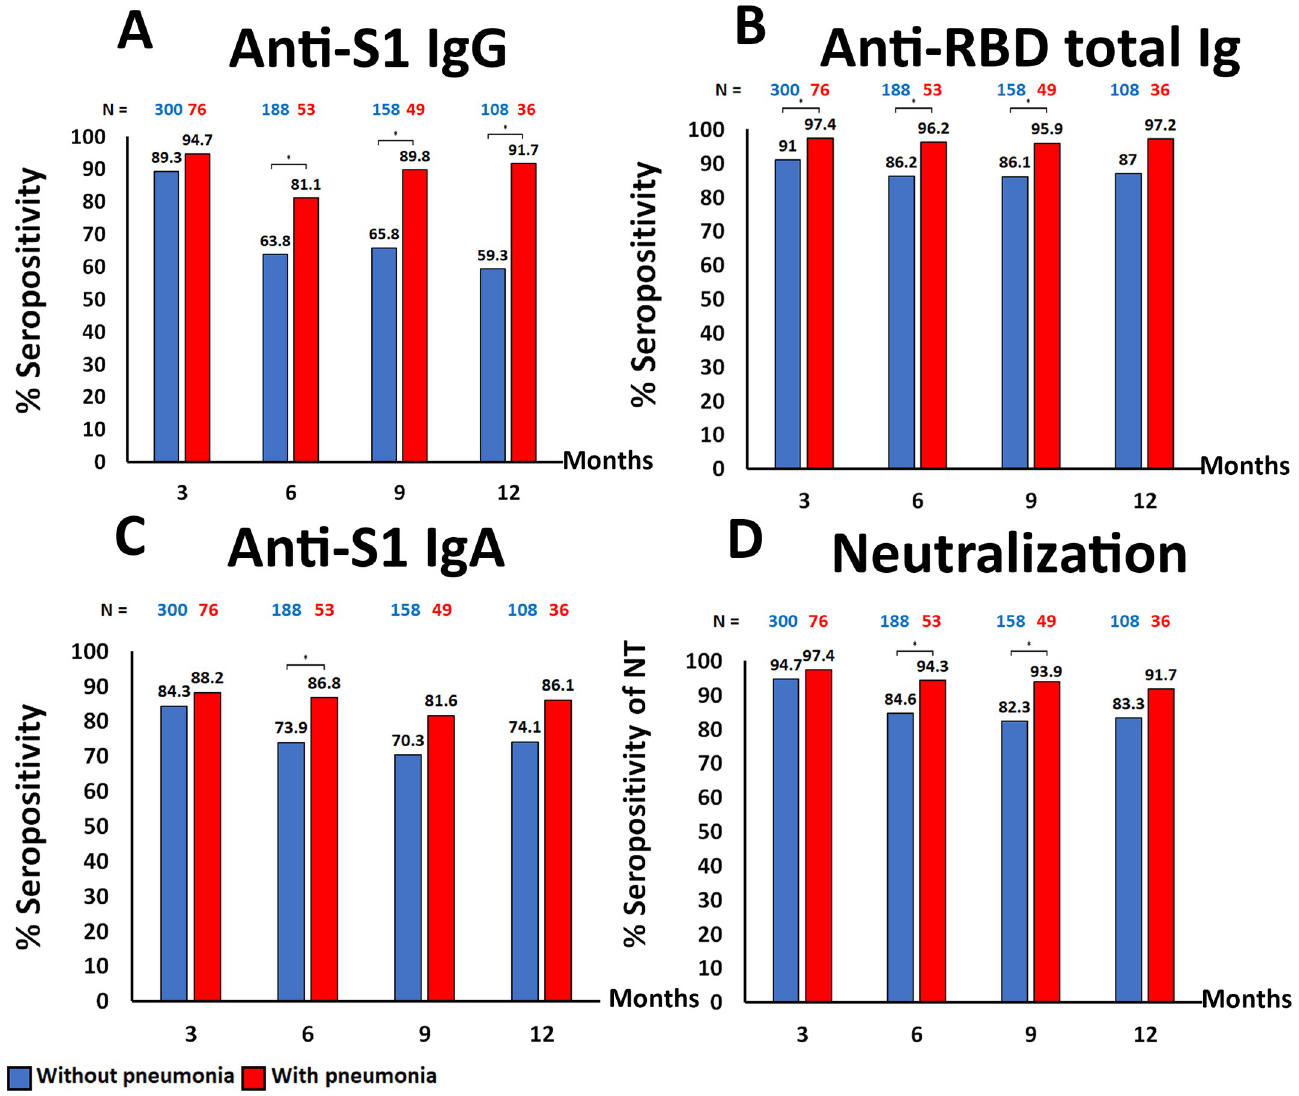
Fig 2. Comparison of seropositivity rate among recovered COVID-19 patients with pneumonia (red) and without pneumonia (blue) at indicated time points after post symptom onset or first SARS-CoV-2 detection by using Chi-square test, ( � = p -value < 0.05). (A) Anti-S1 IgG, (B) Anti-RBD total Ig, (C) Anti-S1 IgA, (D) Neutralizing titer, measured by the virus-neutralizing assay (NT 50 ).